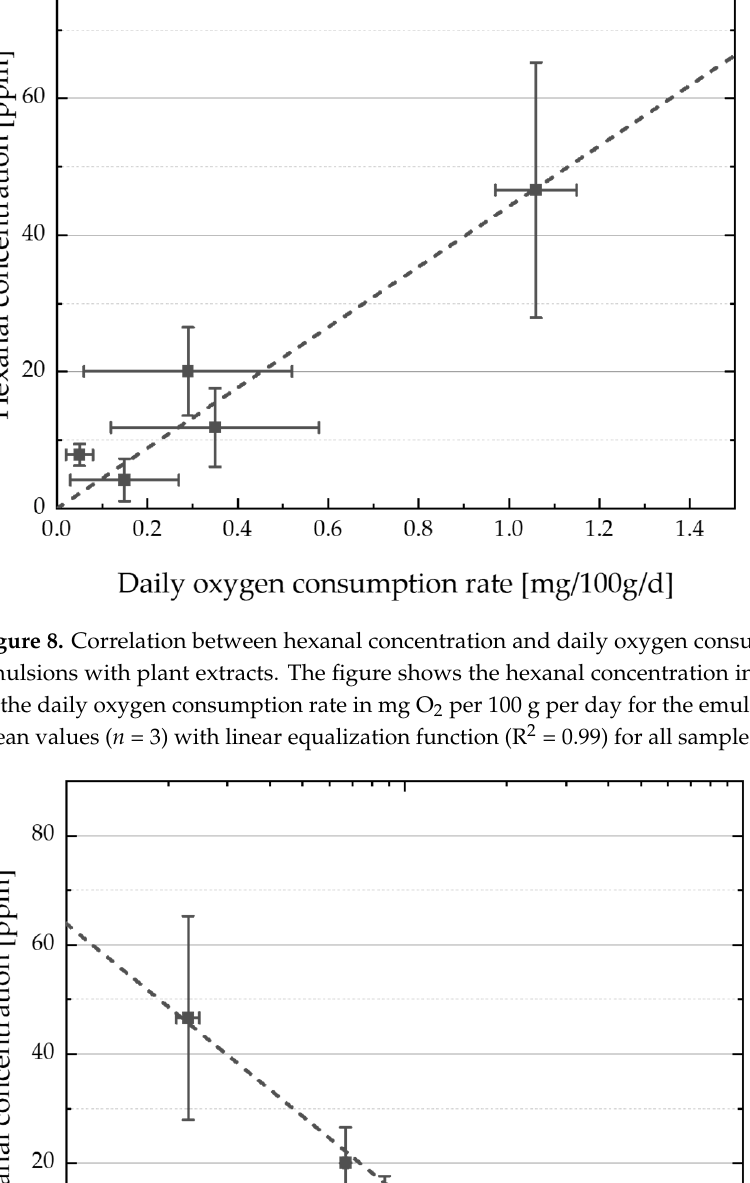
Figure 9. Correlation between hexanal concentration and antioxidant activity of O/W emulsions